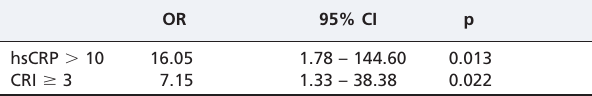
Table 4 - Odds ratio of major cardiac events in logistic regression analysis including hsCRP and